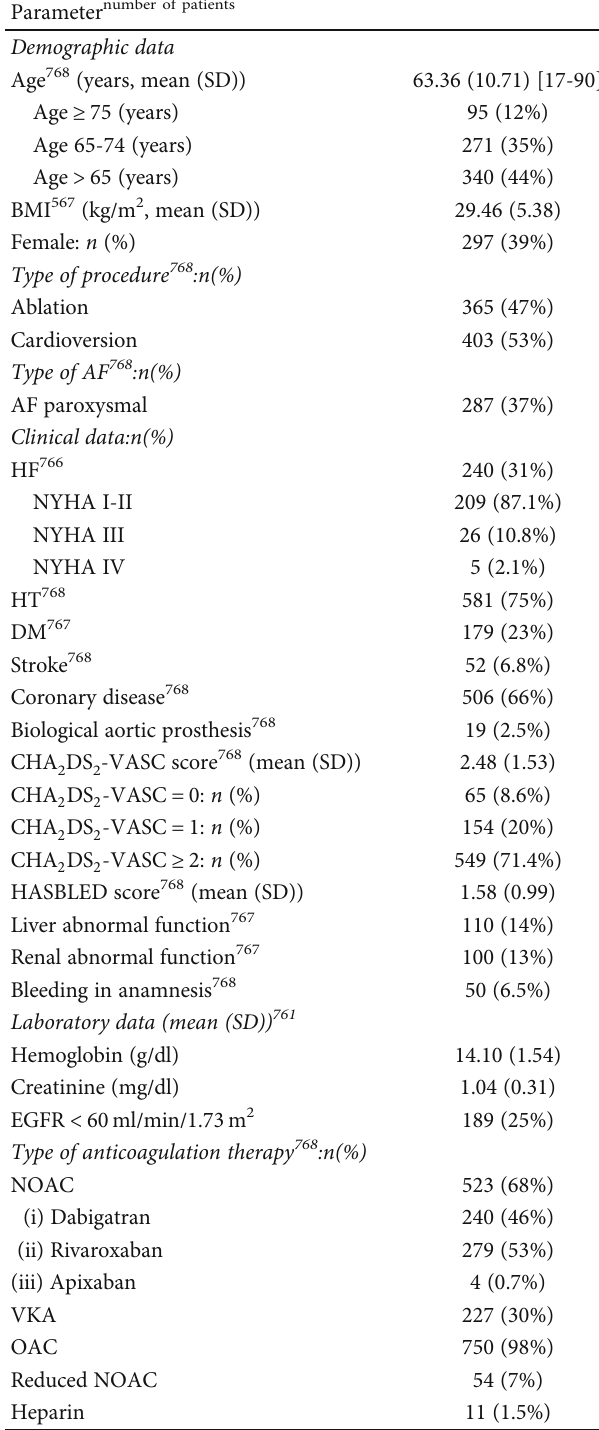
Table 1: Baseline characteristics of the study